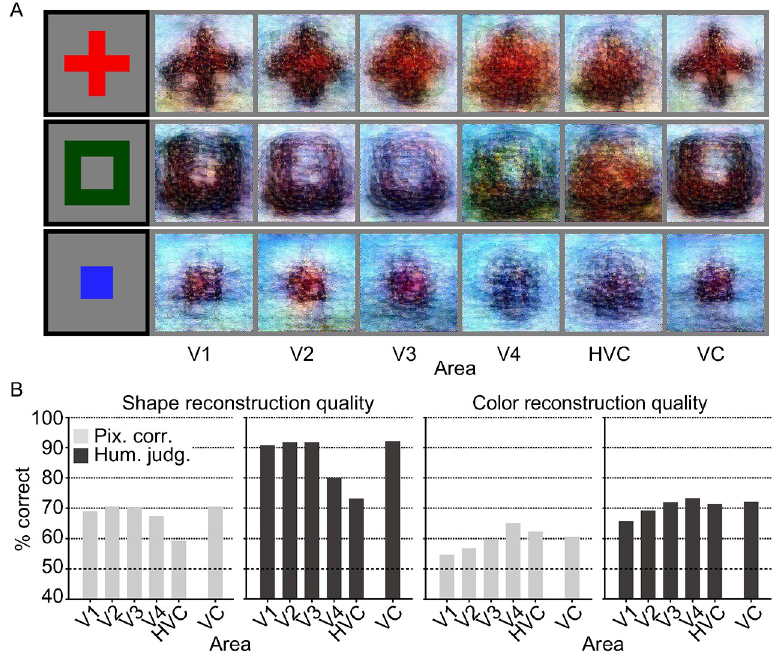
Fig 7. Reconstructions of shape and color from multiple visual areas. ( A ) Reconstructions of artificial shapes from multiple visual areas (DNN 1–8, without the DGN). The black and gray surrounding frames indicate presented and reconstructed images respectively. ( B ) Reconstruction quality of shape and color for different visual areas (three subjects pooled, N = 120; chance level, 50%).